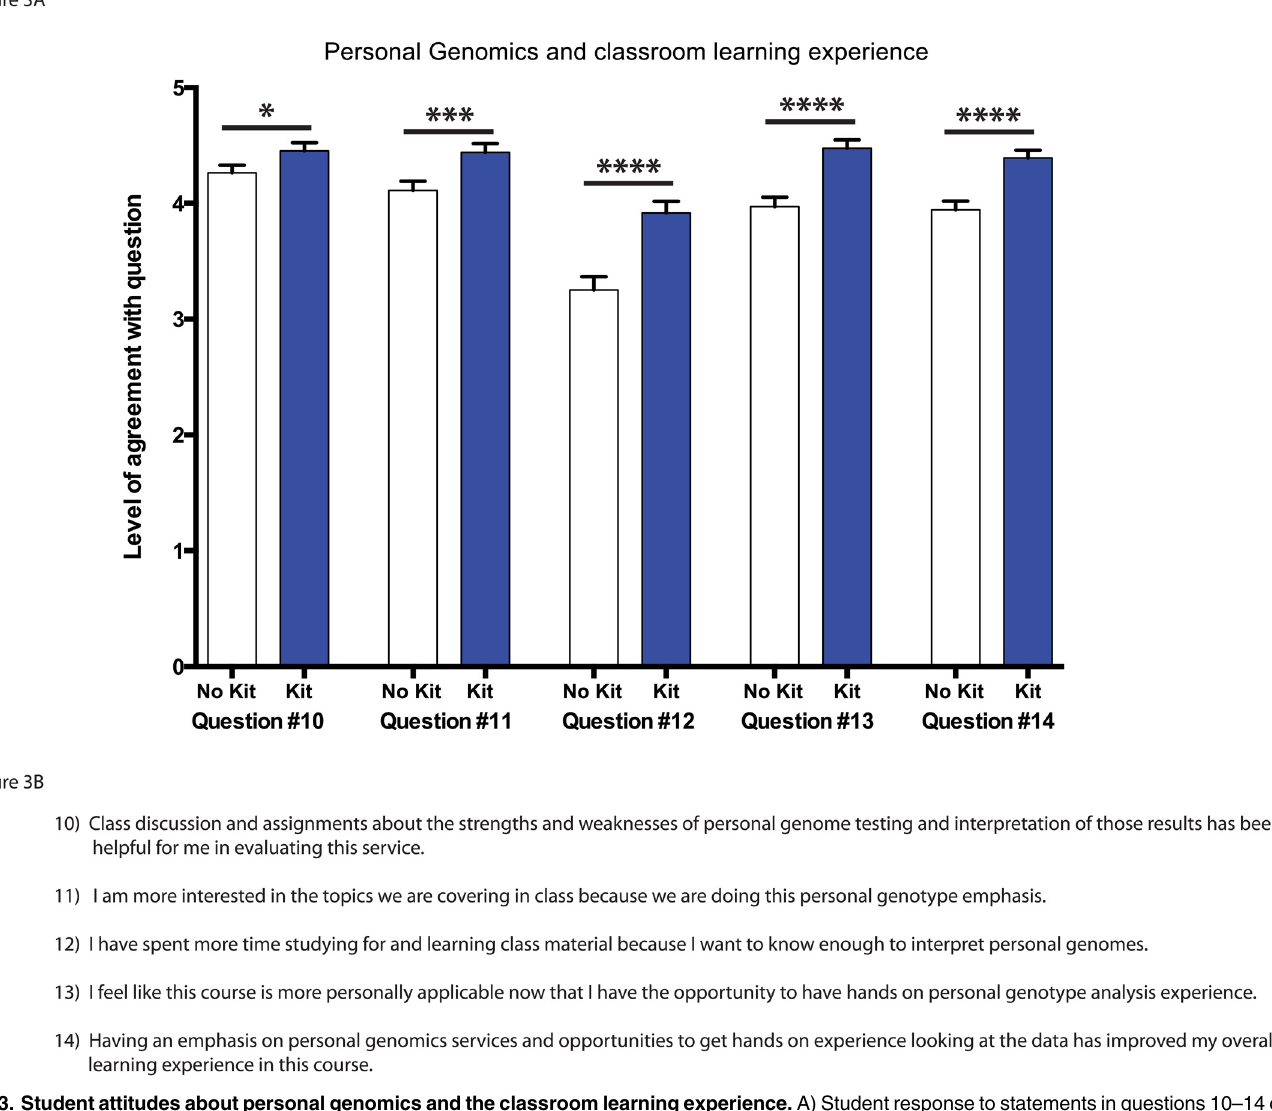
Fig 3. Student attitudes about personal genomics and the classroom learning experience. A) Student response to statements in questions 10 – 14 on a 5-point Likert scale. Statistical analysis performed using the Mann-Whitney U-test and all values are mean ± SEM with n = 71 for no kit (white), and n = 84 for kit (blue) ( * = p < .05; *** = p < .001; **** = p < .0001). B) Student survey questions 10 –